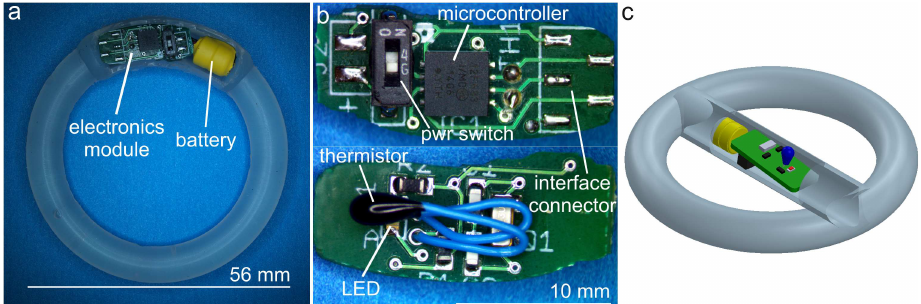
Fig 1. Adherence-monitoring IVR prototype. (a) AdherenceIVR prototype with electronics module embedded in IVR elastomer circumference as used in in vitro simulationexperiments. For clarity, the IVR is shown prior to sealingthe circuit board and cylindricalbattery pack in place using siliconeadhesive.(b) Close- up of prototypeelectronics module.(c) Cutaway3D model of adherenceIVR prototypeused in sheepstudy. The electronicsmodule and battery are enclosedin a central compartment rather than sealed in the IVR circumference to allow access to the electronics duringinitial in vivo evaluation.A portion of the central compartment wall is removed in the drawingto expose the electronics moduleand